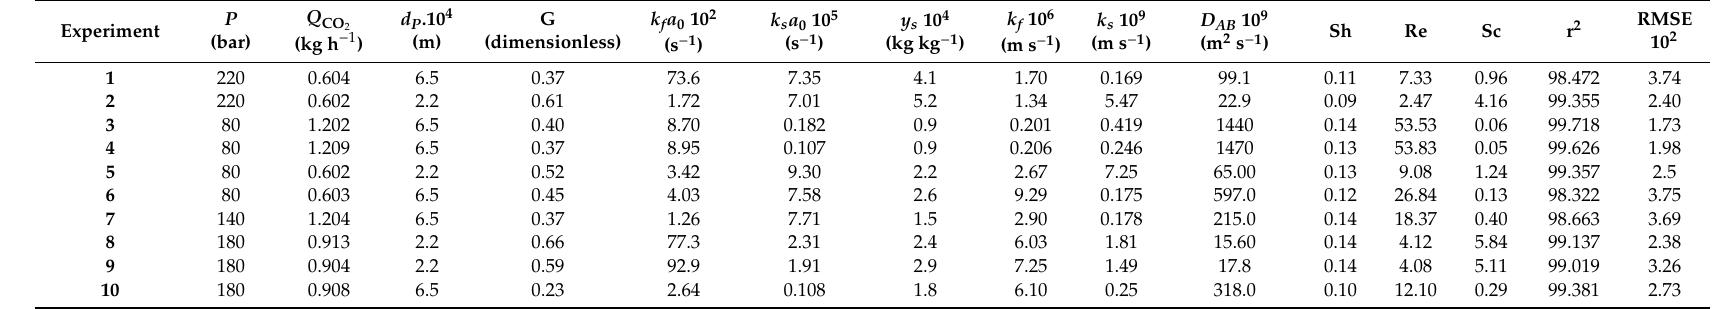
Table A4. Operating conditions estimated THREE parameters from best fitting and modeling errors used by AYDI A.